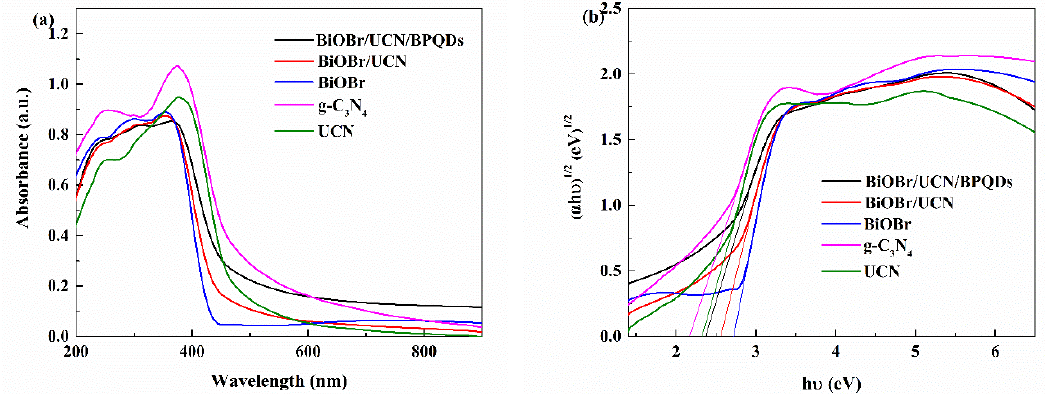
Figure 7. ( a ) UV-visible diffuse reflectance spectra of samples, ( b ) (αhν) 1/2 for photon energy hν